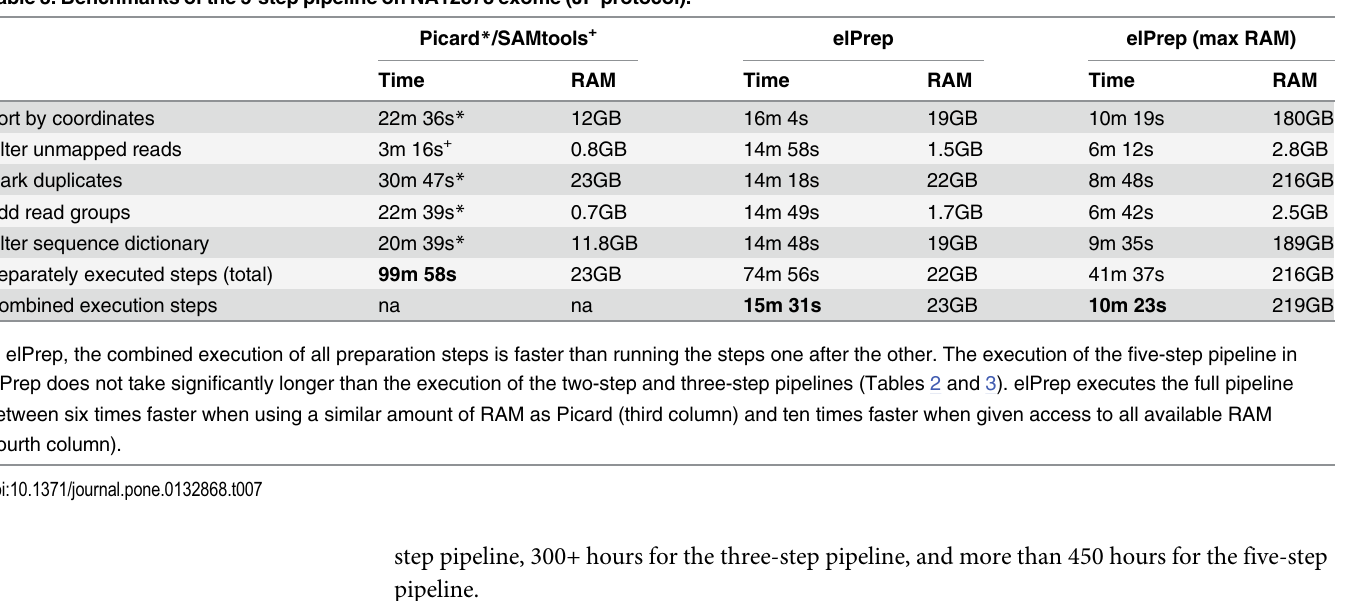
Table 3. Benchmarks of the 5-step pipeline on NA12878 exome (JP